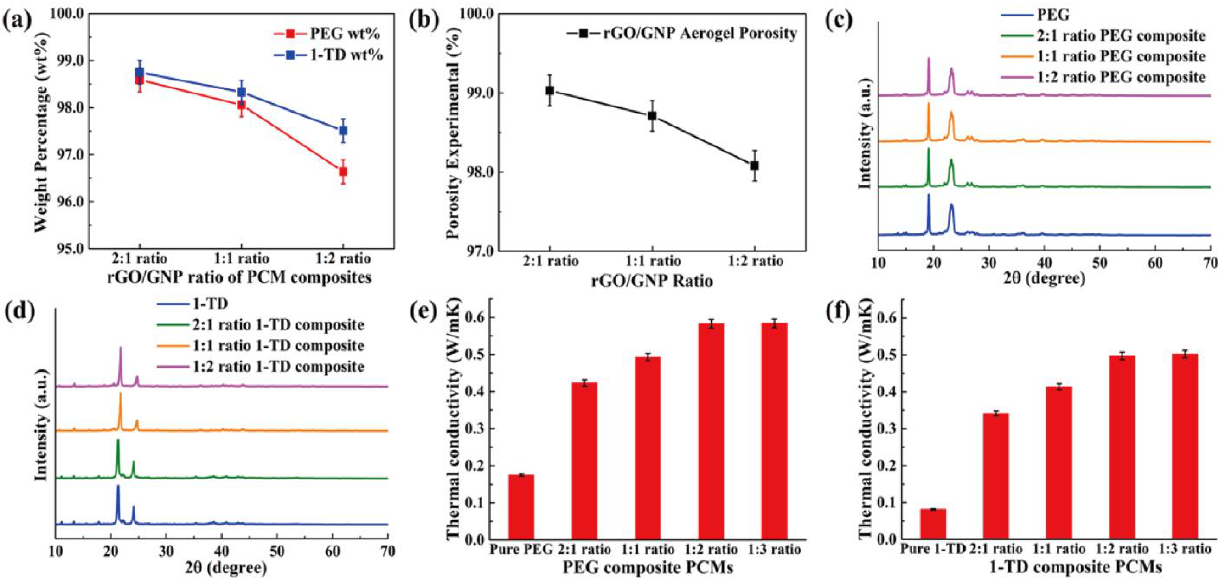
Figure 5. ( a ) Weight percentage of PEG and 1-TD in the PCM composite and ( b ) porosity of rGO/GNP aerogels. XRD peaks of ( c ) pure PEG and PEG composites and ( d ) pure 1-TD and 1-TD composites. Thermal conductivities of ( e ) pure PEG and PEG composites and ( f ) pure 1-TD and 1-TD composites.